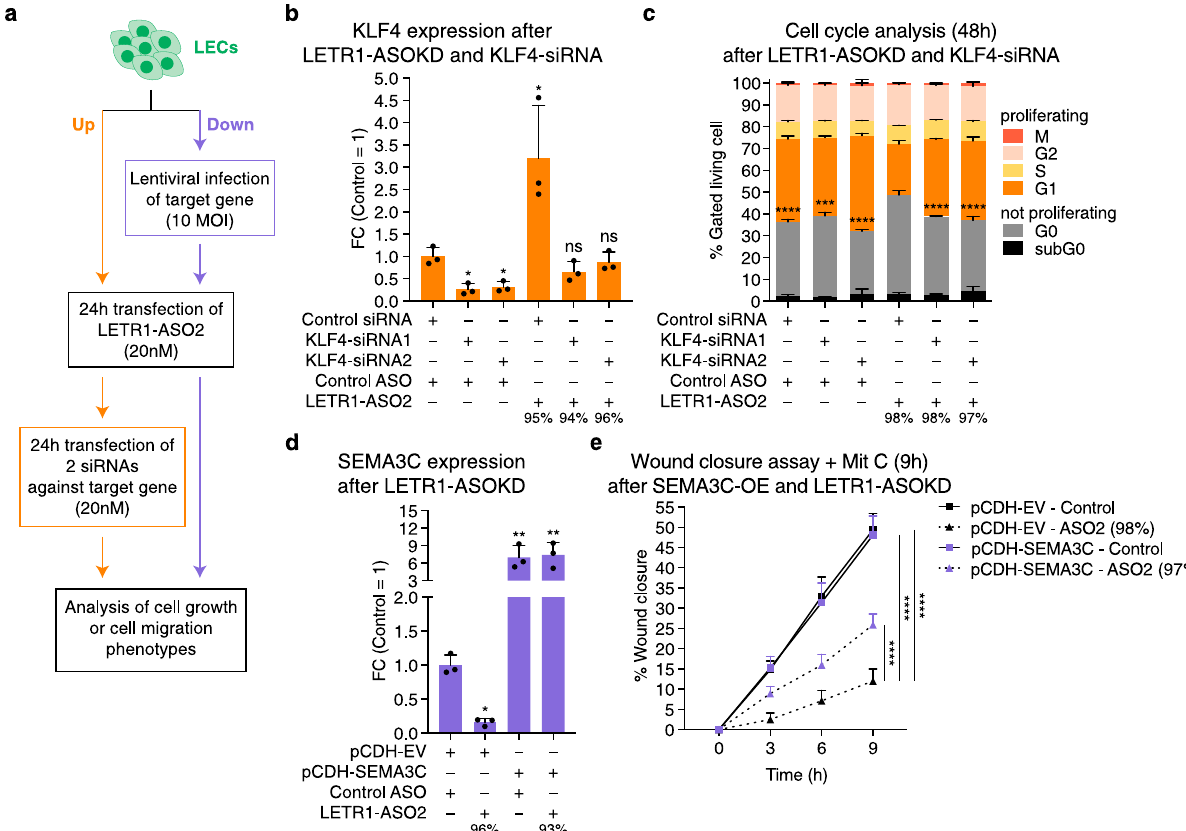
Fig. 7 LETR1 regulates cell proliferation and migration through transcriptional regulation of KLF4 and SEMA3C. a Schematic representation of the experimental strategy to analyze the rescue of LETR1-ASO2 knockdown associated phenotypes with involved up- and downregulated genes after combining LETR1 knockdown and gene targets dysregulation. MOI: multiplicity of infection. b Expression levels of KLF4 after consecutive LETR1-ASO2 knockdown followed by siRNA-KD of KLF4 in neonatal LECs derived from three donors. c Quanti fi cation of the cell cycle progression analysis after 48 h consecutive knockdown of LETR1 and KLF4. Statistical analysis was performed on G0 populations. d Expression levels of SEMA3C after LETR1-ASO2 knockdown in pCDH-EV and pCDH-SEMA3C infected neonatal LECs derived from three donors. e Quanti fi cation of wound closure assay (up to 9 h) in neonatal LECs after the combination of SEMA3C overexpression and LETR1-ASO2 knockdown. Wound closure percentages were determined using TScratch 109 . Data are displayed as mean values + SD ( n = 3 in b – d ; n = 10 in e ). Percentages represent the knockdown ef fi ciencies of LETR1 after